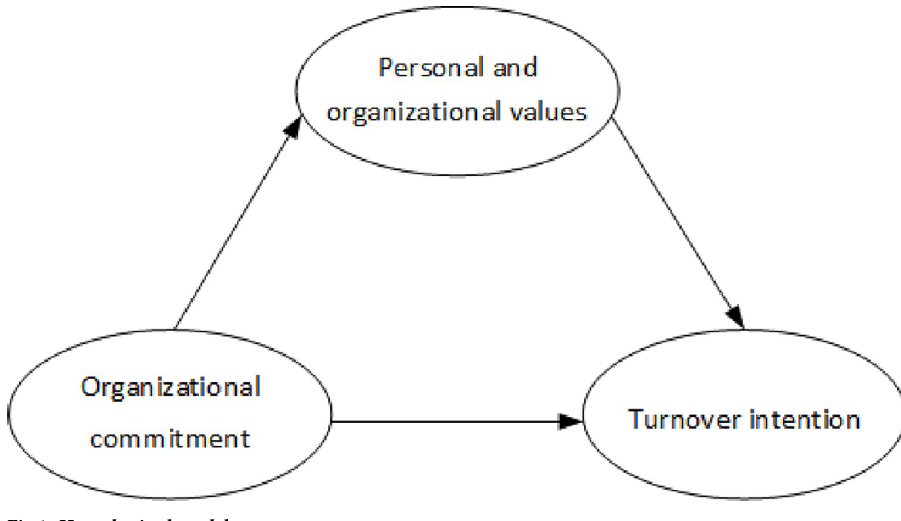
Fig 1. Hypothesized